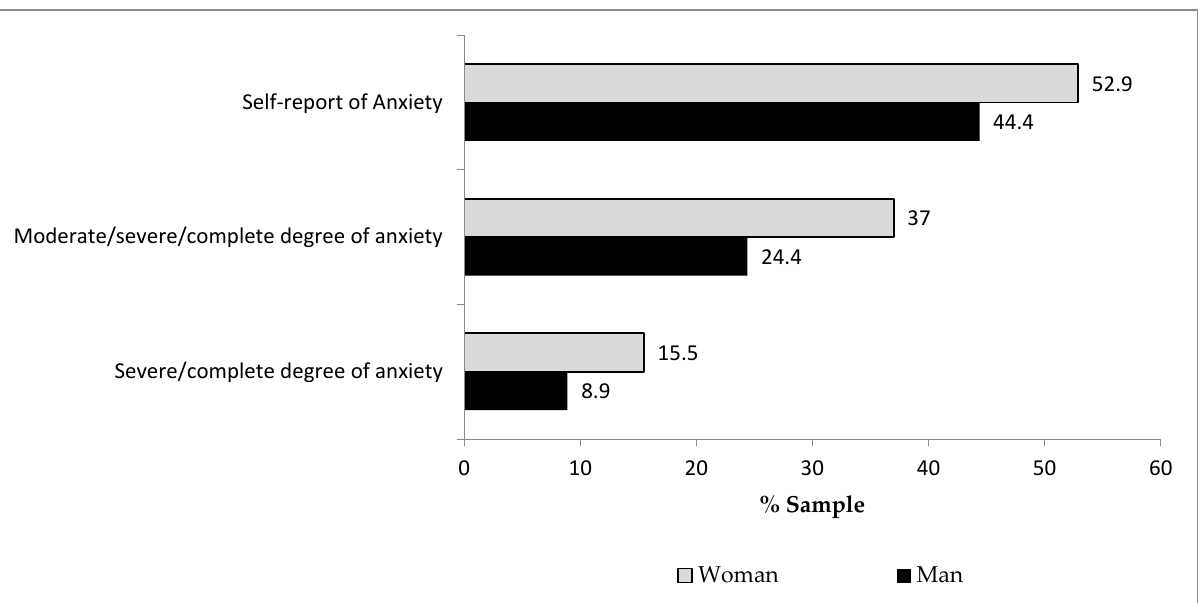
Figure A4. Self-report of anxiety according to the professional’s gender.